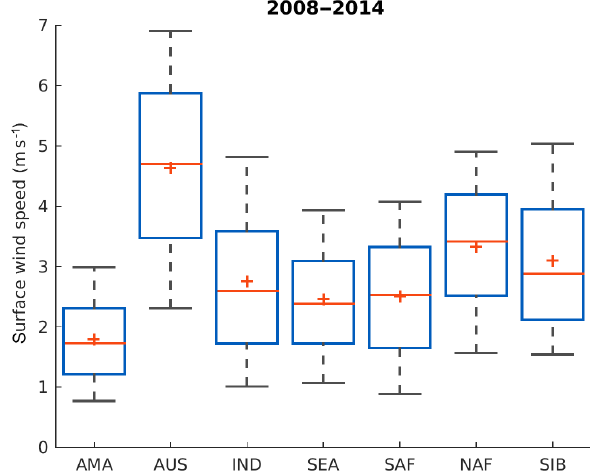
Figure 3. Box and whisker plots showing the mean (red central cross), median (red central line), and 25th and 75th percentiles (blue box edges) of surface wind speed for each MODIS hotspot over the studied regions (AMA = Amazonia, AUS = Australia, IND = India, SEA = Southeast Asia, NAF = northern Africa, SAF = southern Africa, SIB = Siberia). The whiskers en- compass values from the 25th − 1.5 × (75th − 25th) to the 75th + 1.5 × (75th − 25th) percentiles. This range of values corre- sponds to approximately 99.3% coverage if the data are normally